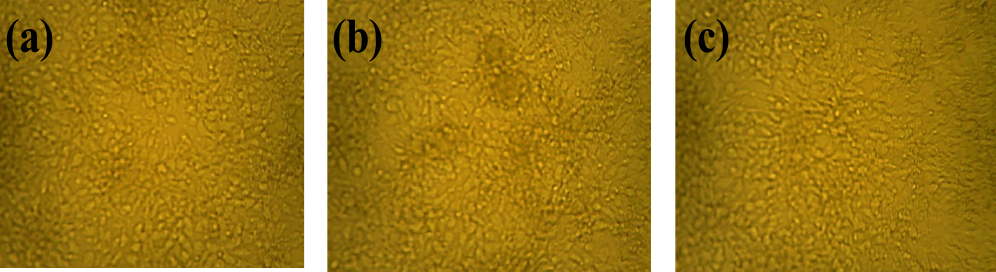
Figure 7. The images of viable cells with the optical microscope of Sm 2 O 3 /MgO/GO@CA ( a – c ); ( −−−−− 500 µm).